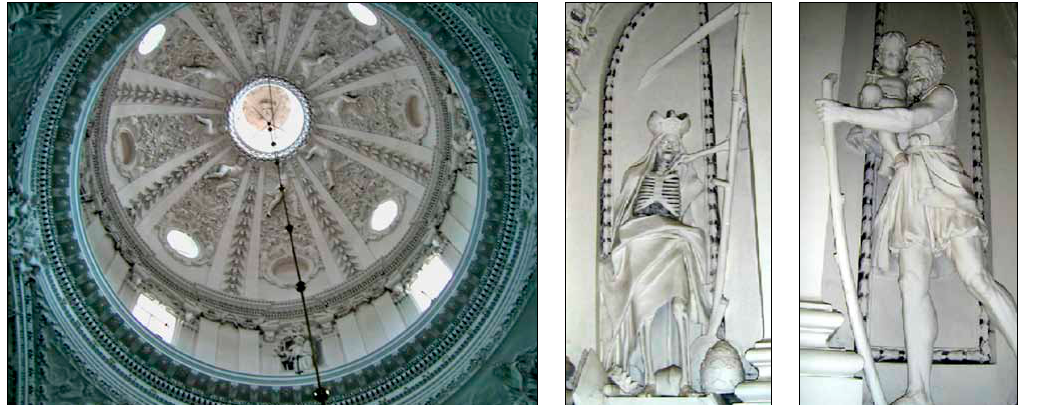
fig. 6. Interior decoration of St. Peter and St. Paul’s Church: the dome, the statue of Death and the statue of